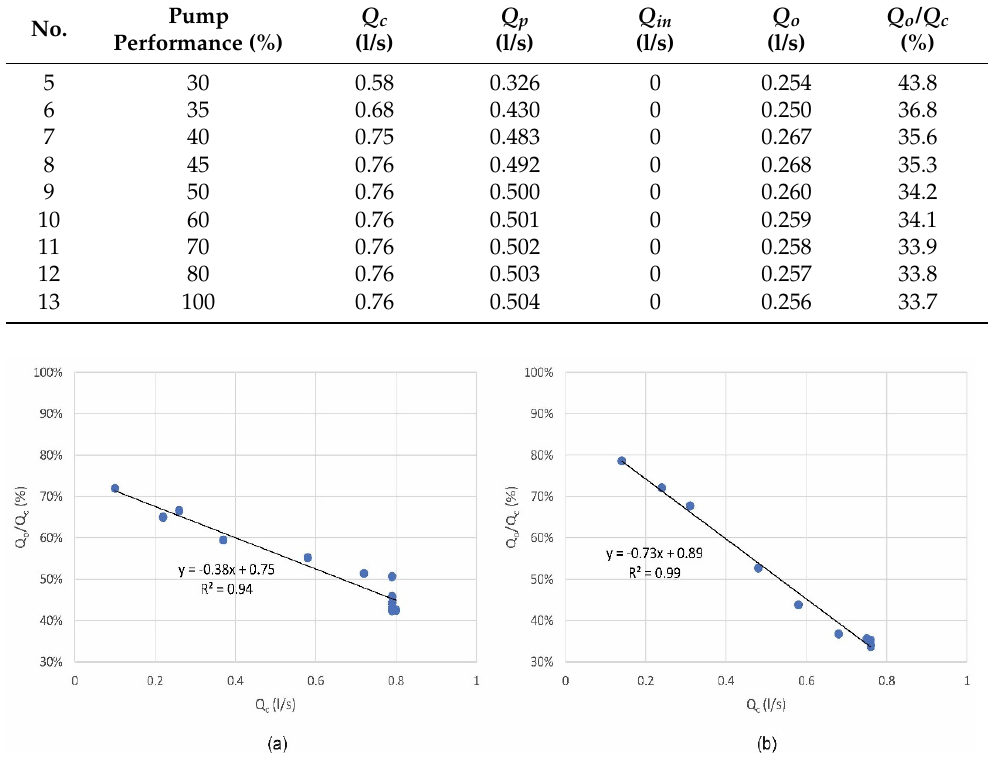
Figure 10. Pilot test on the HJ-3 extraction well on 2 July 2020: ( a ) measured profile 11.75 m b.g.l.; ( b ) measured profile 15.75 m b.g.l.